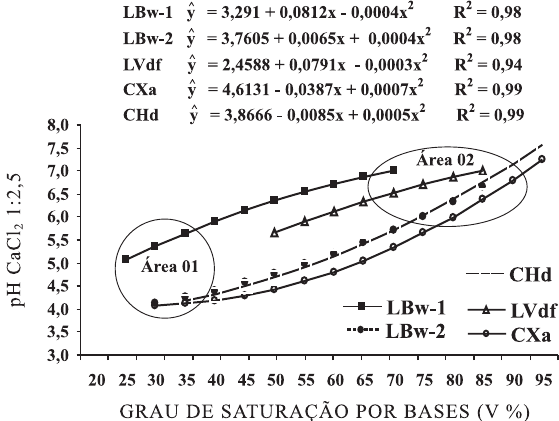
Figura 3. Relação entre pH em CaCl equilíbrio e grau de saturação por bases (V) dos solos, onde foram aplicadas doses de CaO para o V calculado de 25, 45, 60, 70, 100, 125 e 150 %.